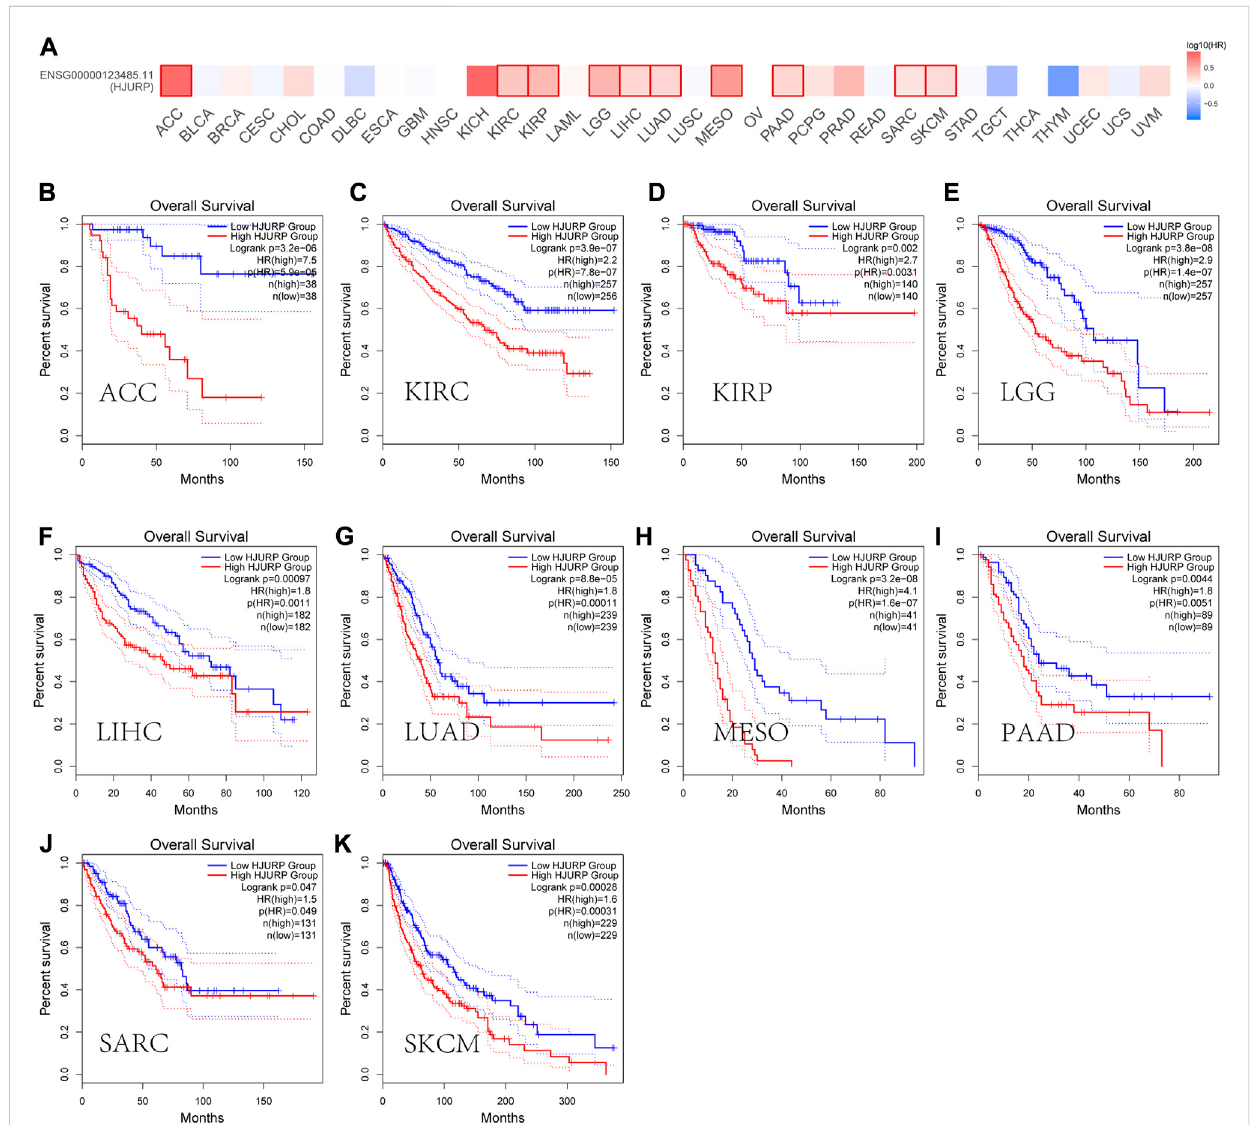
FIGURE 3 Prognostic roles of HJURP in pan-cancer. (A) Prognostic pattern of HJURP in pan-cancer were analyzed using GEPIA database. (B-K) The GEPIA database was used to assess the correlation of HJURP with OS of different tumor types.